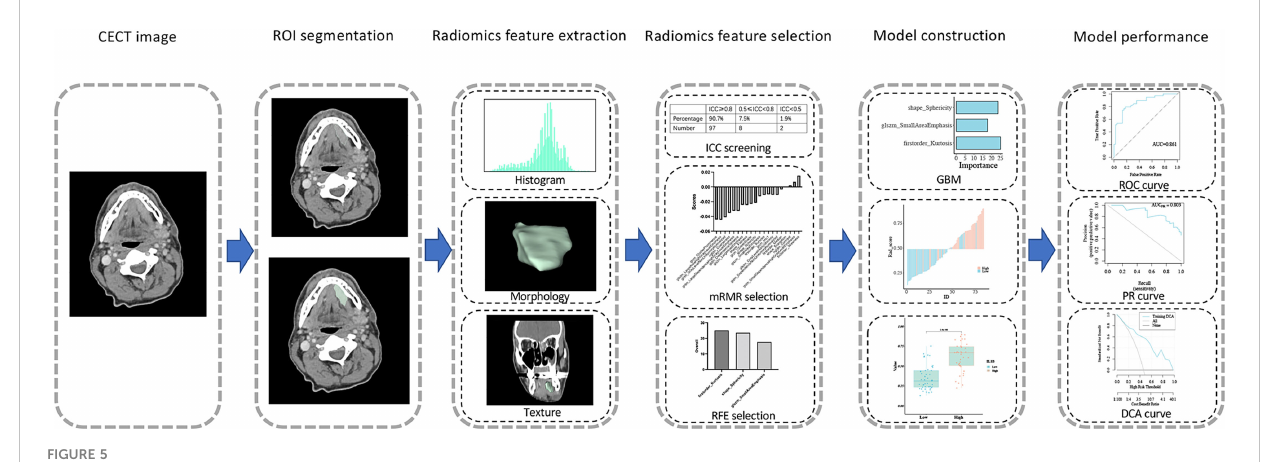
FIGURE 5 Work fl ow of construction and evaluation of the radiomics